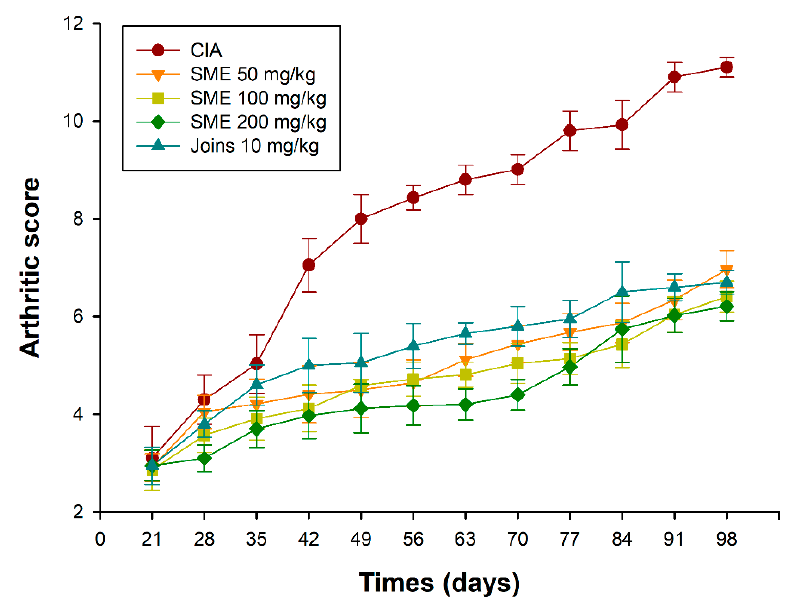
Figure 1. Effects of the Sargassum muticum extract on the arthritis score. CIA, collagen-induced arthritis vehicle control group; SME 50 mg/kg, group provided with 50 mg/kg of S. muticum extract; SME 100 mg/kg, group provided with 100 mg/kg of S. muticum extract; SME 200 mg/kg, group provided with 200 mg/kg of S. muticum extract; Joins 10 mg/kg, positive control.